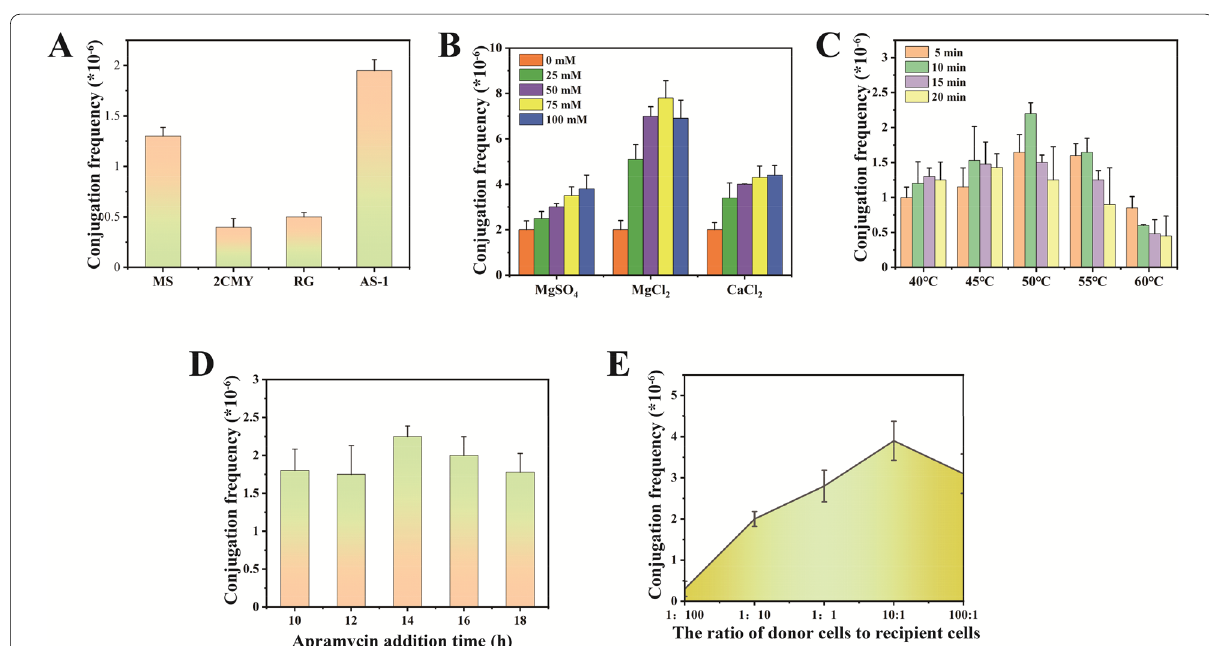
Fig. 1 Optimization of the conjugation conditions between strain SF-2 and E . coli . A Effect of A medium, B metal ions species and concentration, C heat shock conditions, D antibiotic addition time, and E donor:receptor cells ratio on conjugation